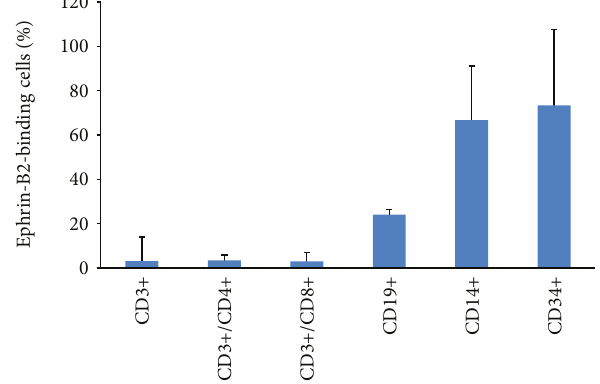
Figure 9: Percentage of PB-MNC subpopulations binding ephrin- B2/Fc ( N = 5 – 6 ). Data are presented as mean ±